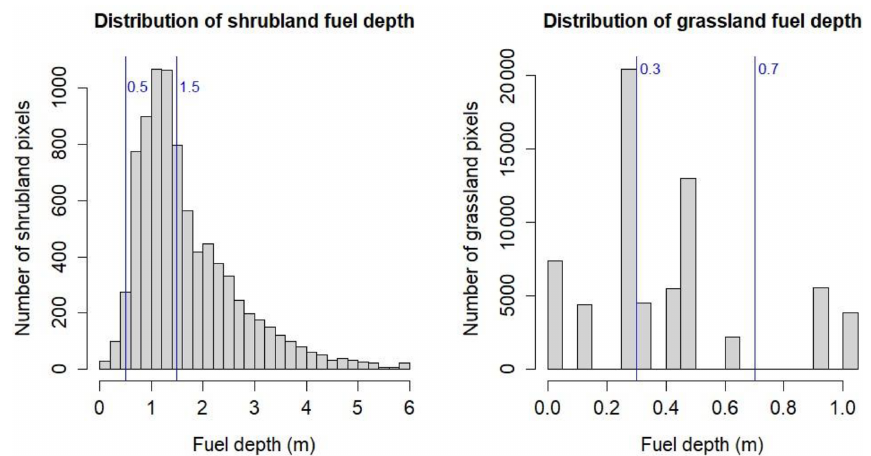
Figure 4. Histograms for shrubland and grassland fuel bed depth (m) in Europe obtained from the application of the bioclimatic models. The blue lines represent the fuel bed depth threshold used to subdivide shrubland and grassland fuel